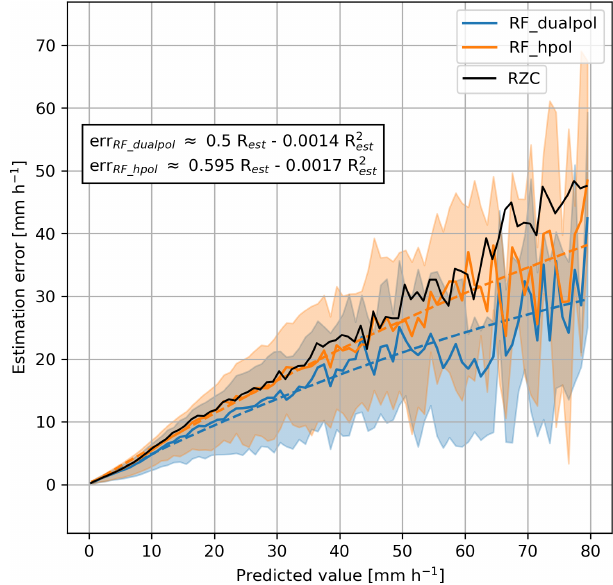
Figure 12. Absolute error of the precipitation estimate as a func- tion of the precipitation estimate, evaluated over five iterations of a five-fold cross-validation, for the two RF models. The colored semi-transparent area corresponds to the Q25–Q75 interquantile, the solid lines to the mean and the dashed line to a polynomial fit, whose formulation is shown in the box on the left. The solid black line corresponds to the average error of the RZC model which is shown as a reference. All quantiles and means have been ob- tained using a discretization on the predicted values with a step of 1mmh − 1